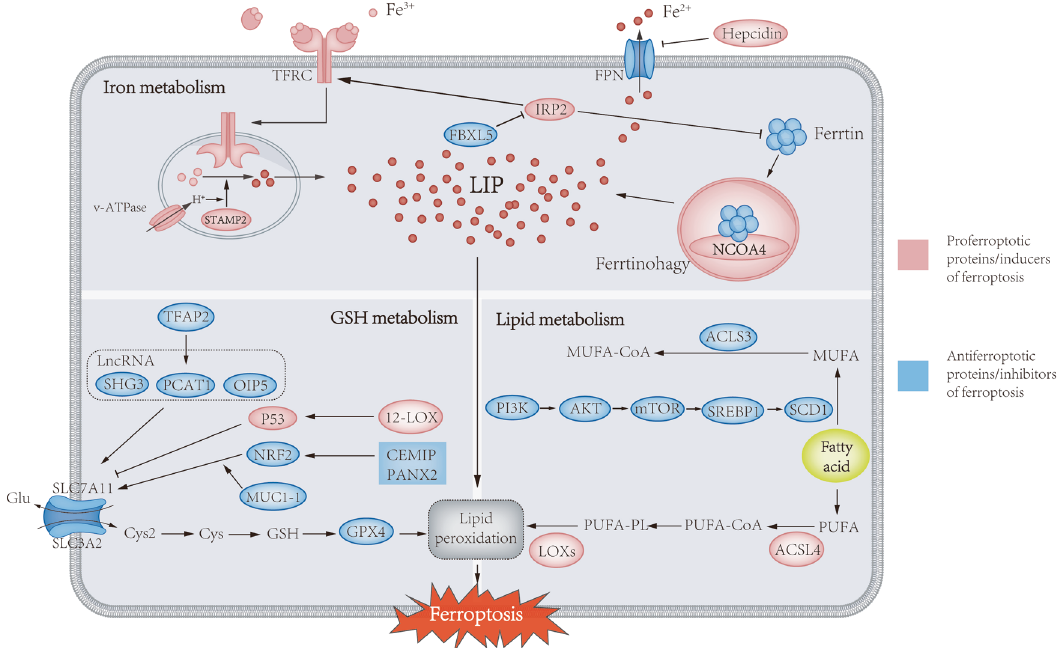
Fig. 1 Metabolic pathways implicated in ferroptosis in prostate cancer. Ferroptosis is mainly caused by iron-related lipid peroxidation, and the absorption, storage, utilization and export of iron in iron metabolism will affect ferroptosis. STAMP2-mediated ferric iron reduction and NCOA4-mediated ferritin autophagy can increase labile iron pools to sensitize cells to ferroptosis via the Fenton response. The classical inhibitory pathway of ferritin metabolism is mainly uptake of Cys by the cystine-glutamate antiporter (system xc − ), which is used for the synthesis of GSH. GPX4 utilizes GSH as a cofactor to reduce lipid hydroperoxides to lipid alcohols. In addition, the activation of ACSL4, LPLAT5, and LOXs in the lipid metabolism pathway can promote the peroxidation of PUFA and induce ferroptosis. Conversely, the PI3K/AKT/mTOR pathway is able to promote SREBP1/SCD1-mediated MUFA formation and convert MUFAs to their acyl-CoA esters under the action of ACSL3 for incorporation into membrane phospholipids, thereby protecting cancer cells from